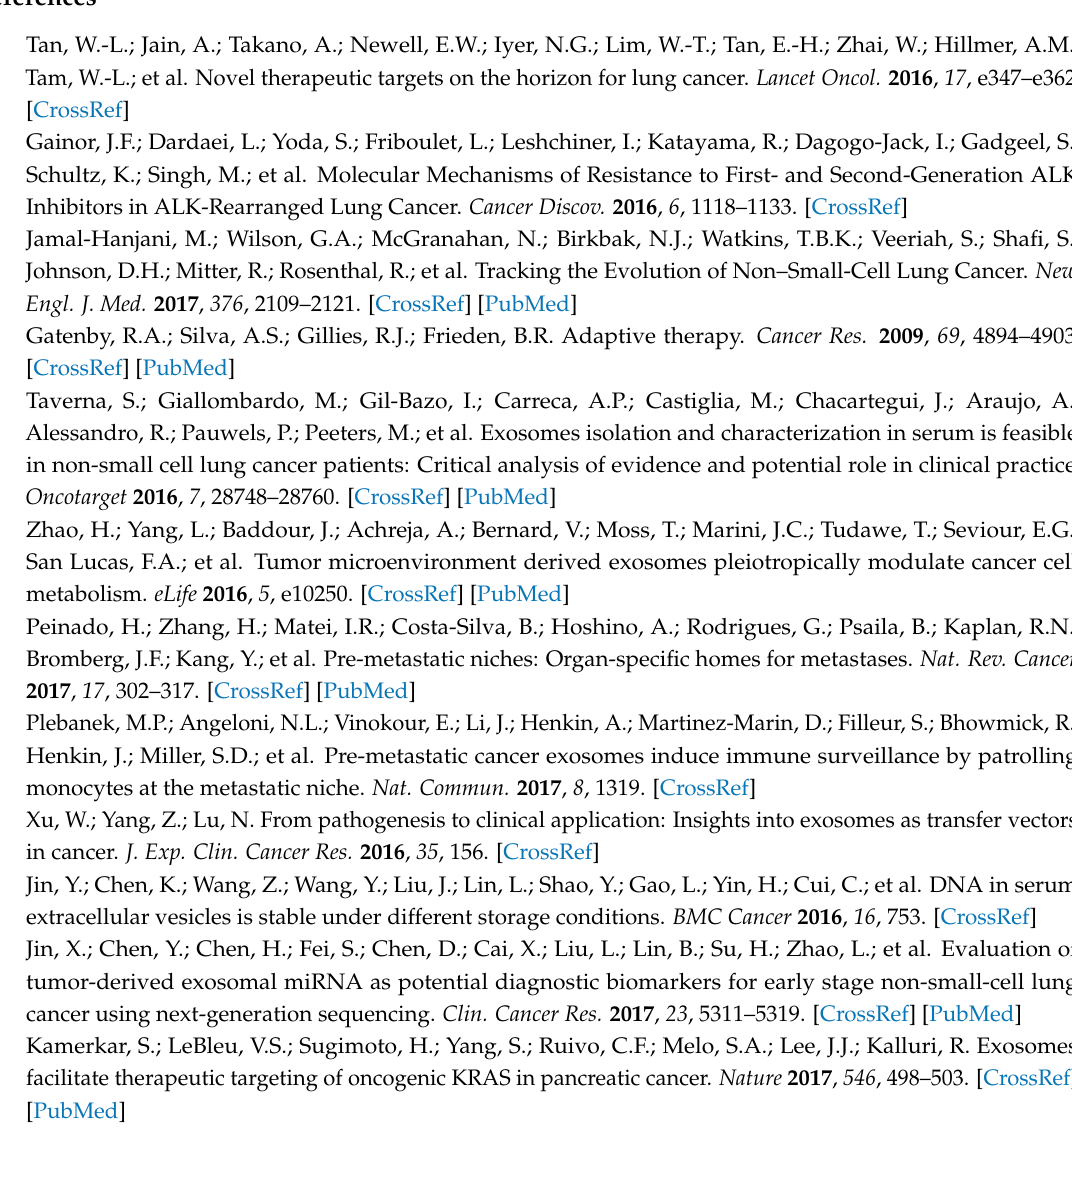
Figure S1: Effects of EVs transfer from ALK-TKI resistant subclones to sensitive subclones on cell migration. Figure S2: Complete expression profiles of serum EV-associated miRNAs in two ALK -translocated patients. Table S1: List of primers used in this